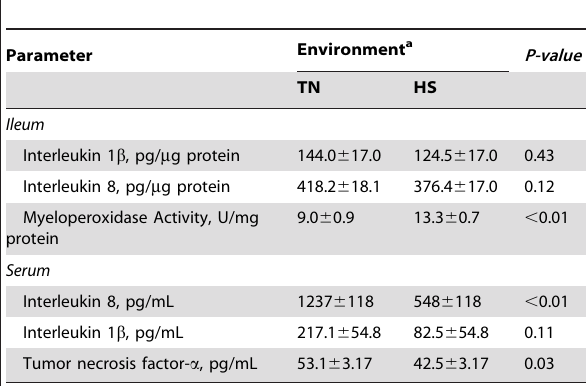
Table 4. Ileum and serum inflammatory responses are differentially modulated after 24 h of thermal neutral (TN) or heat stress (HS) conditions in growing